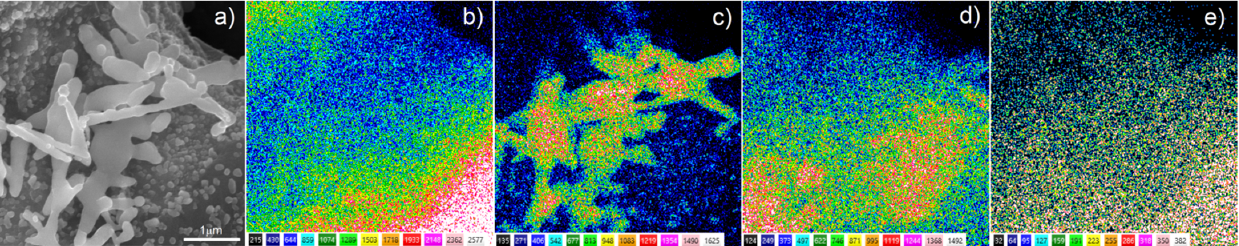
Figure 8. EDS mapping of the Ti20Nb5Zr +Ag foam: ( a ) SEM image; ( b ) Ti; ( c ) Ag; ( d ) Nb; ( e ) Zr. Lighter-colored areas correspond to higher concentration of the element.